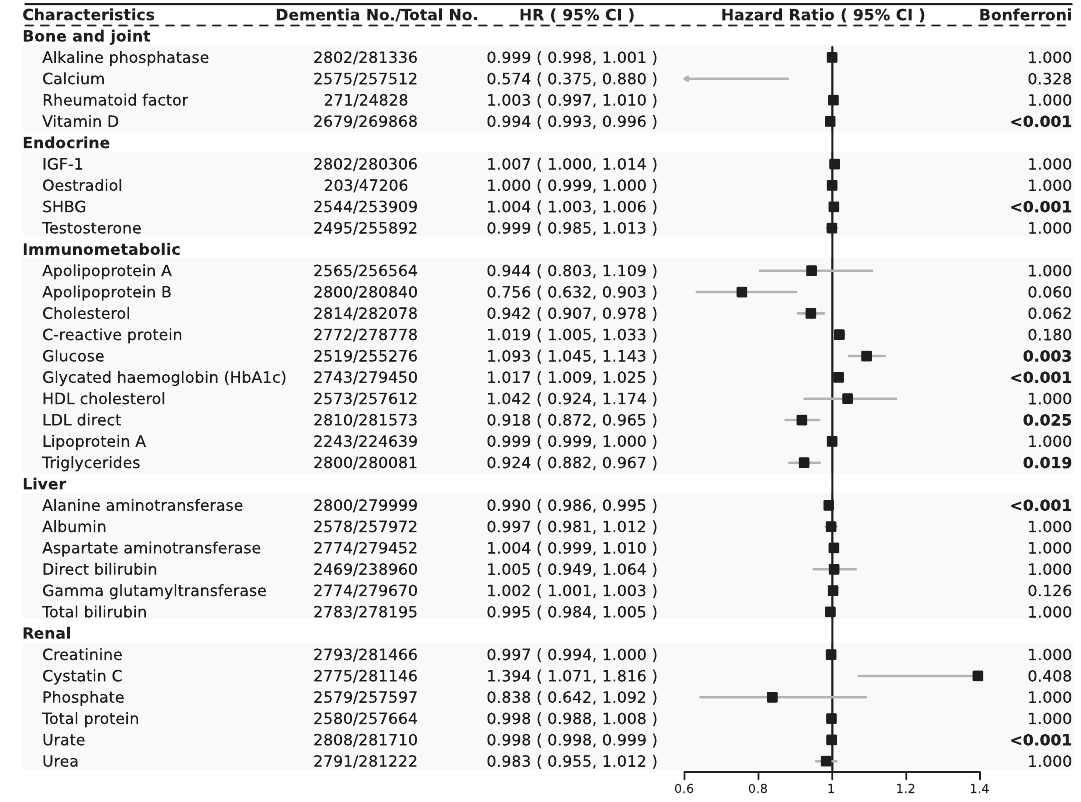
Fig. 2 Linear associations between serum laboratory tests and risk of incident dementia. The hazard ratios present here were calculated by the Cox model 2. Bonferroni column in bold indicates statistical signi fi cance at a Bonferroni adjusted p <